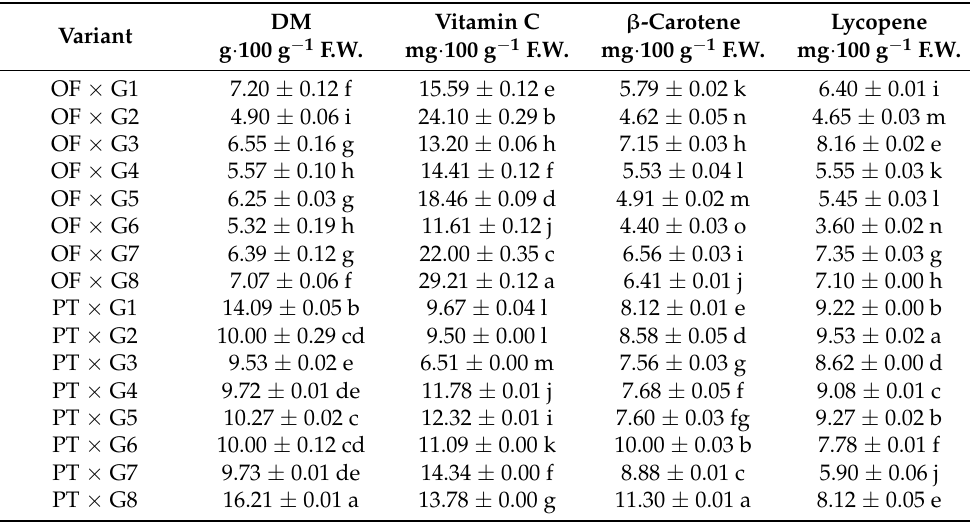
Table 5. The influence of the crop system and genotype on the antioxidant